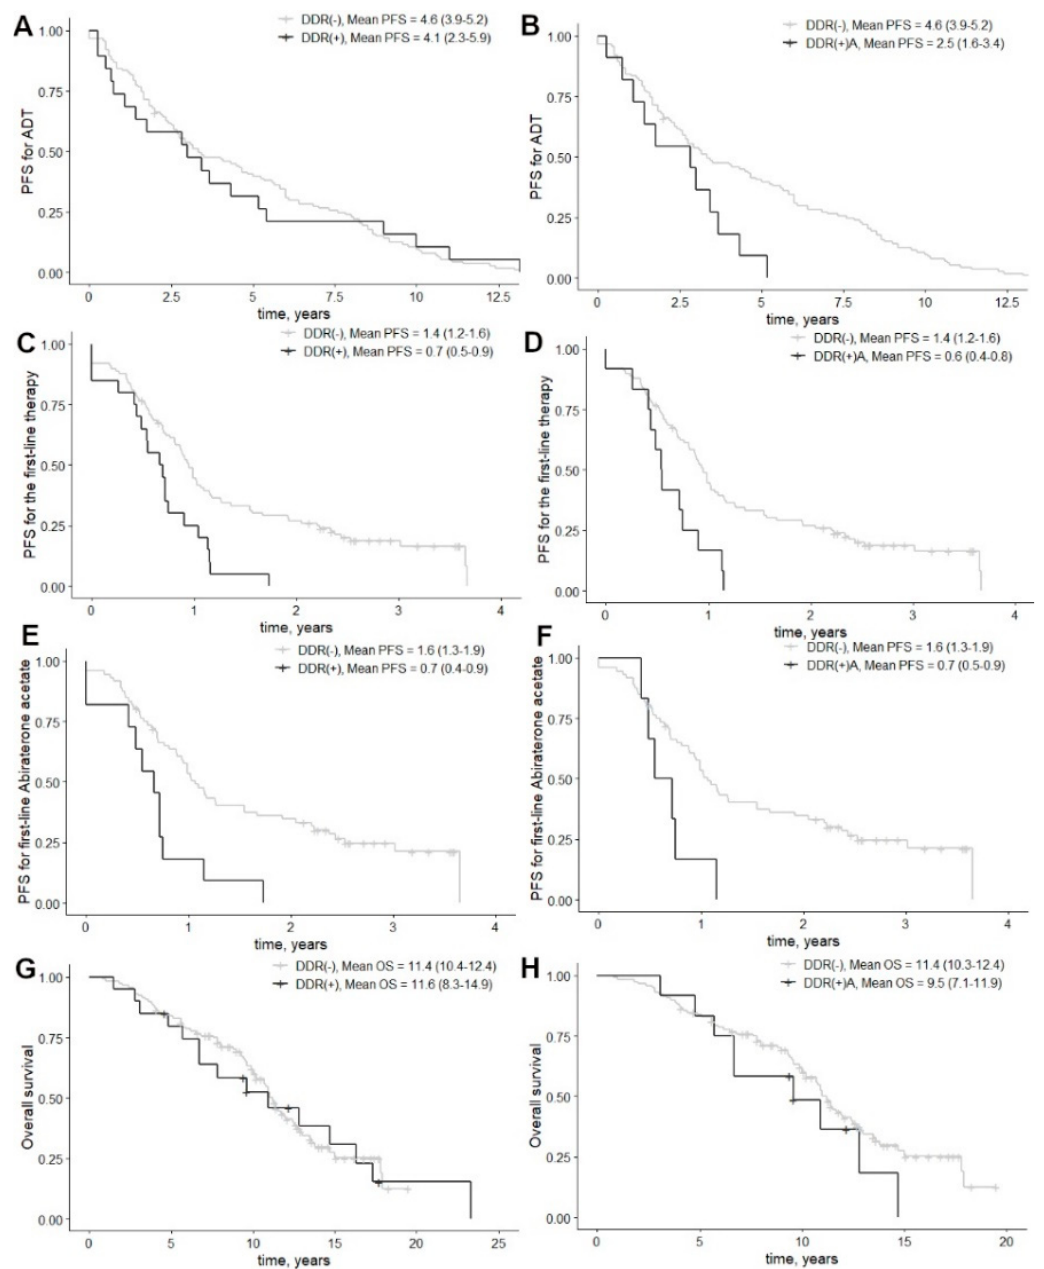
Figure 2. Progression-free survival for ADT in HSPC, the first-line therapy in mCRPC and overall survival. Graphs are supplied as DDR(+) vs. DDR( − ) and DDR(+)A vs. DDR( − ) for: ADT in HSPC ( A , B ), the first-line therapy ( C , D ), the first-line therapy with abiraterone acetate ( E , F ) and overall survival ( G , H ). The 95% confidence intervals are presented in brackets. Abbreviations: ADT—androgen deprivation therapy; HR—hazard ratio; HSPC—hormone-sensitive prostate cancer; PFS—progression-free survival.